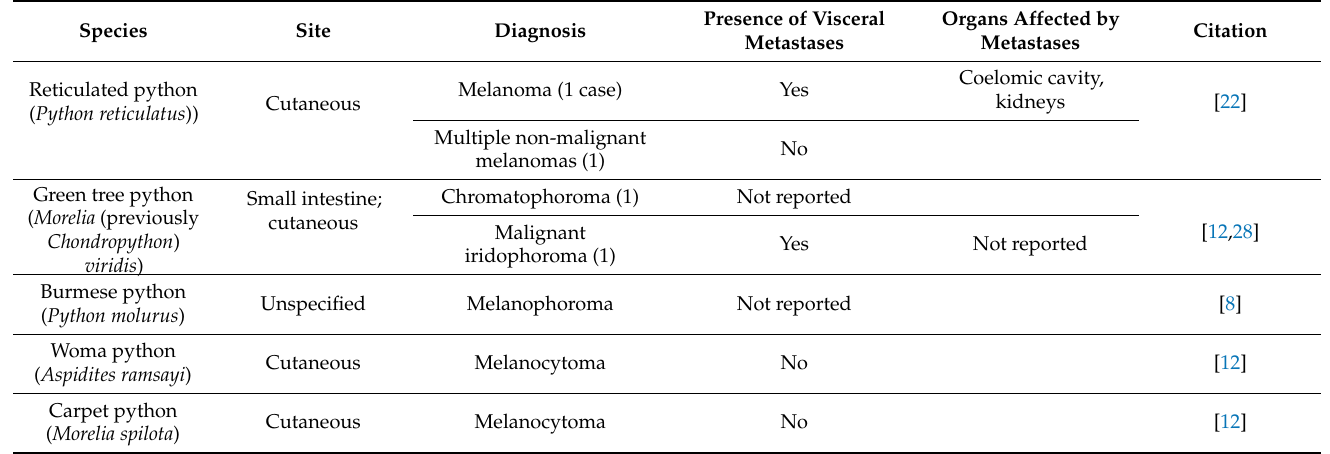
Table 9. Clinical features of chromatophoromas in the reptile family: Pythonidae